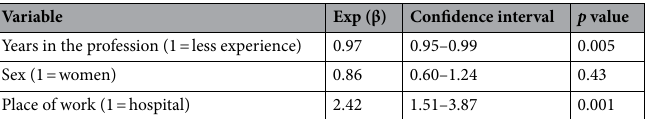
COVID-19 specific ward (N = 66)